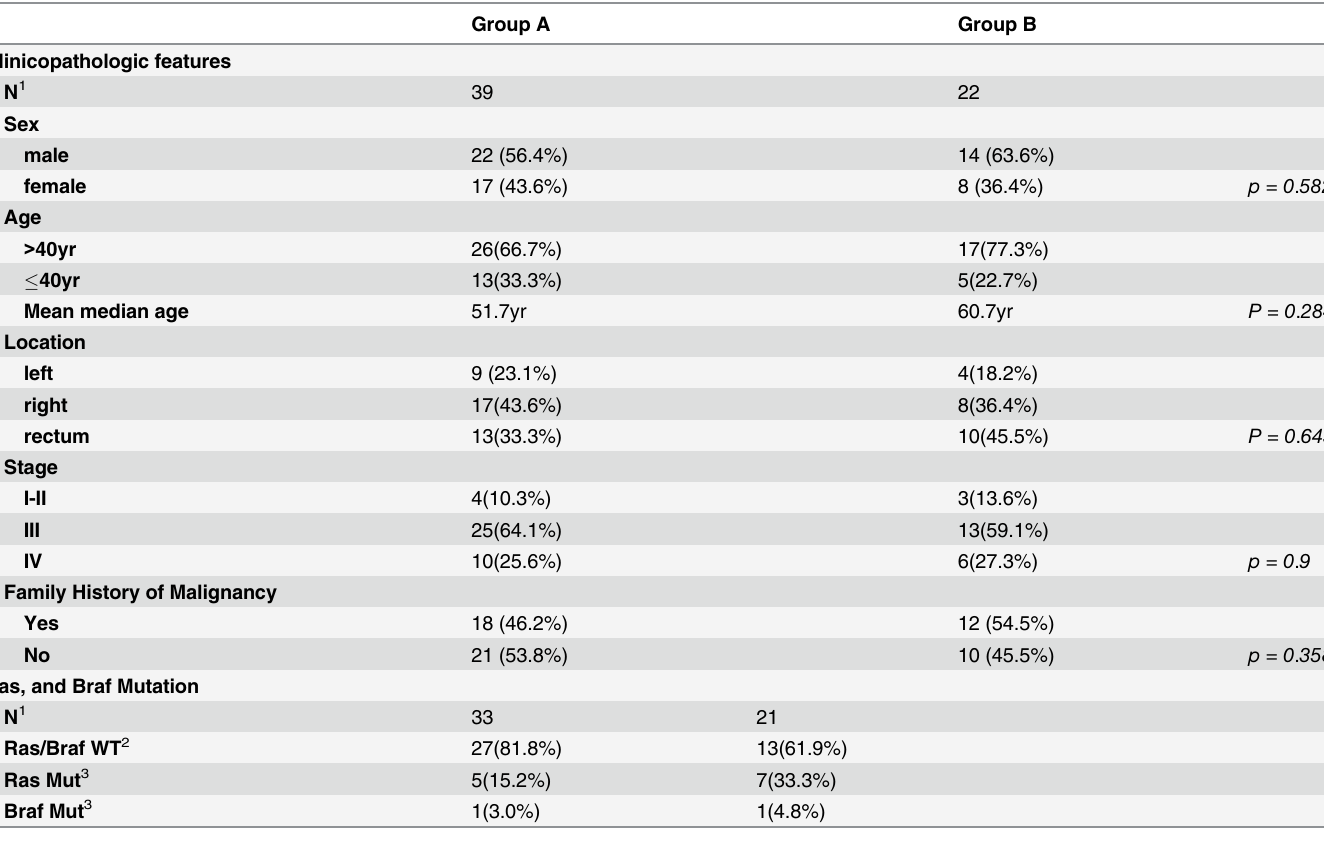
Table 4. Clinicopathologic features of colorectal adenocarcinomas stratified by signet-ring cell